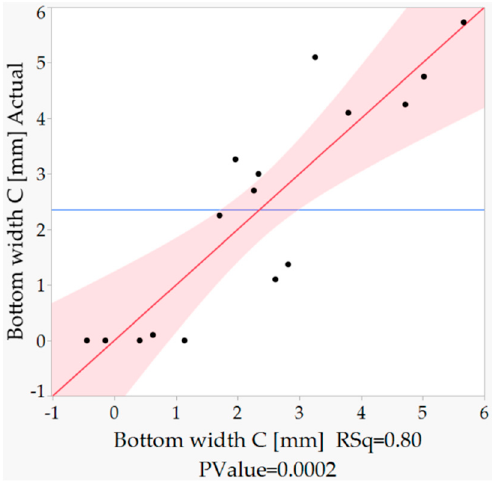
Figure 10. Actual by predicted for bottom width C (penetration).